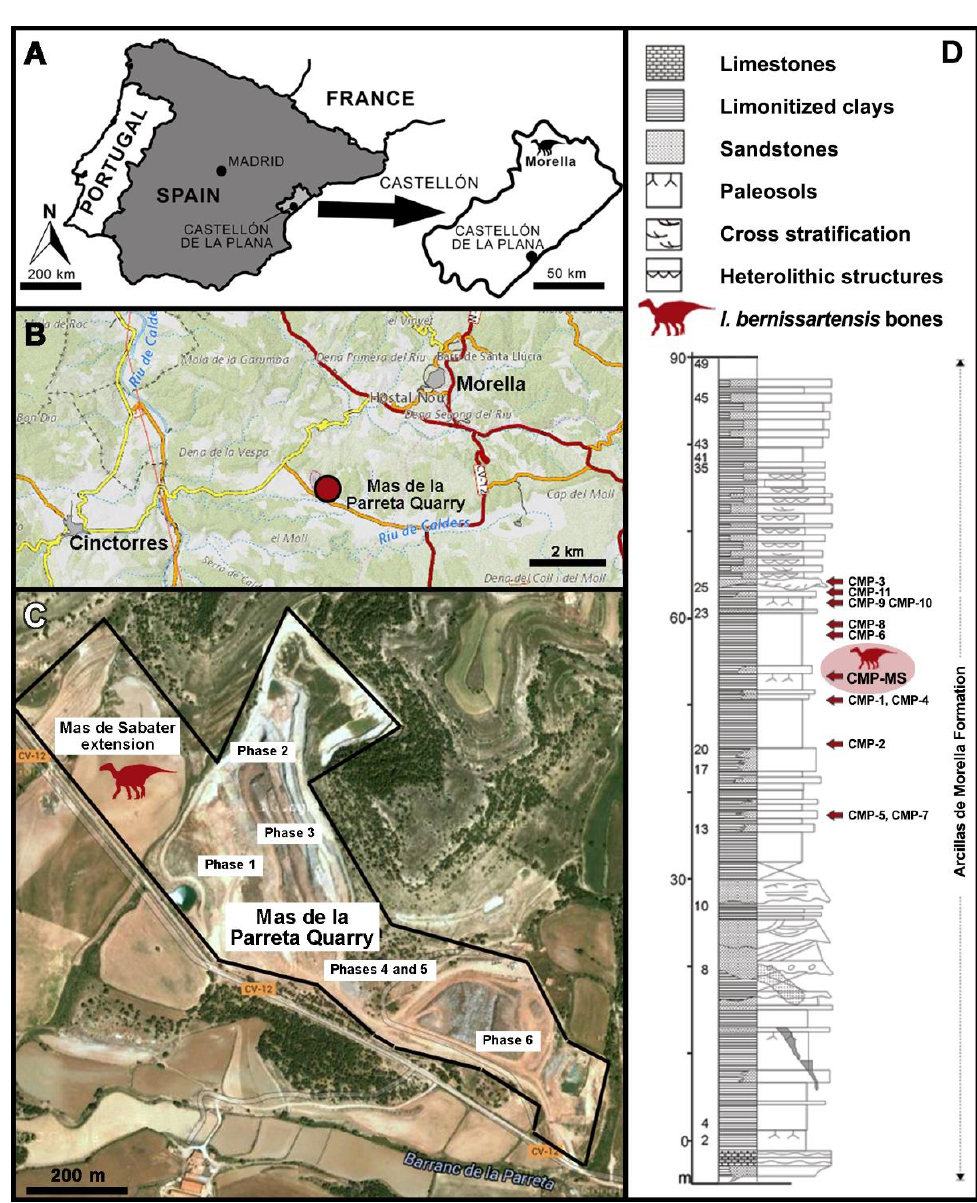
Figure 1. Geographic location of the specimen CMP-MS-04. ( A ) Castellón province and Morella locality in Spain; ( B ) Schematic regional map of area of Morella locality indicating location of the Mas de la Parreta Quarry (red circle) (modified from Visor Cartografic de la Generalitat: https://visor.gva.es/visor/, accseed on 24 October 2021); ( C ) Aerial photograph showing the site in which the specimen CMP-MS-04 was located (Mas de Sabaté extension) within Mas de la Parreta Quarry (modified from Google Maps: https://www.google.es/maps/, accseed on 24 October 2021); ( D ) Simplified stratigraphic column from the exploitation of the quarry showing the distribution of sedimentary environments and the location of CMP fossil sites including CMP-MS area (light red oval). Phases 1 – 6 represent distinct extractive clay activities at Mas de la Parreta Quarry by Vega del Moll S.A. company.